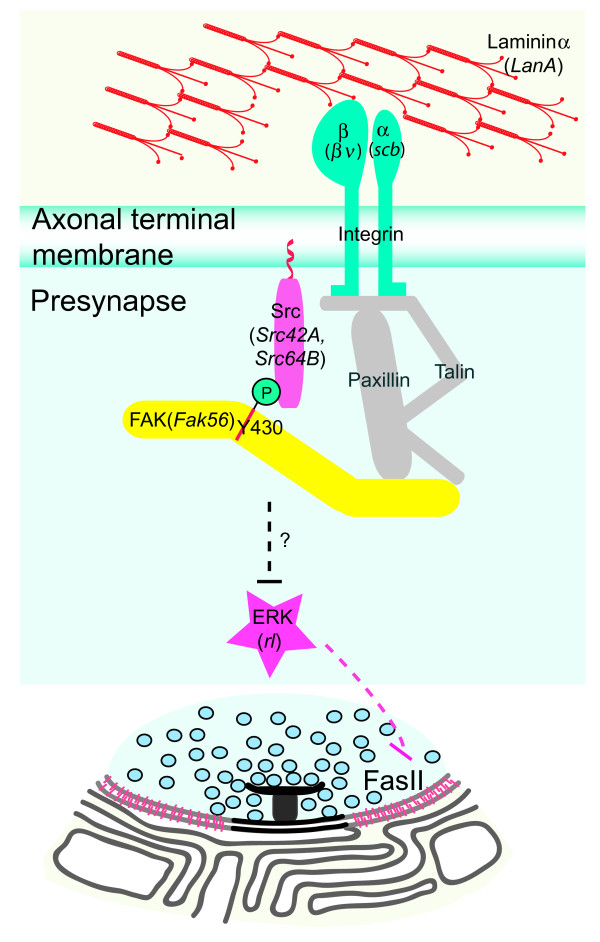
Model to depict Fak56 and ERK signaling and Fasciclin II (FasII) protein levels at neuromuscular junctions (NMJs). In restricting NMJ growth, the extracellular matrix signal laminin including the α subunit LanA is received by integrin receptors, including αPS3 and βν subunits. This signal is transduced through the association between Fak56 and Src, and in this process phosphorylation of Y430 Fak56 is essential. Activated Fak56 mediates signaling through suppressing ERK activation at NMJs and consequently upregulates the FasII protein level at NMJs, leading to the inhibition of NMJ growth. Those molecules (shown in grey) were not tested in this study.